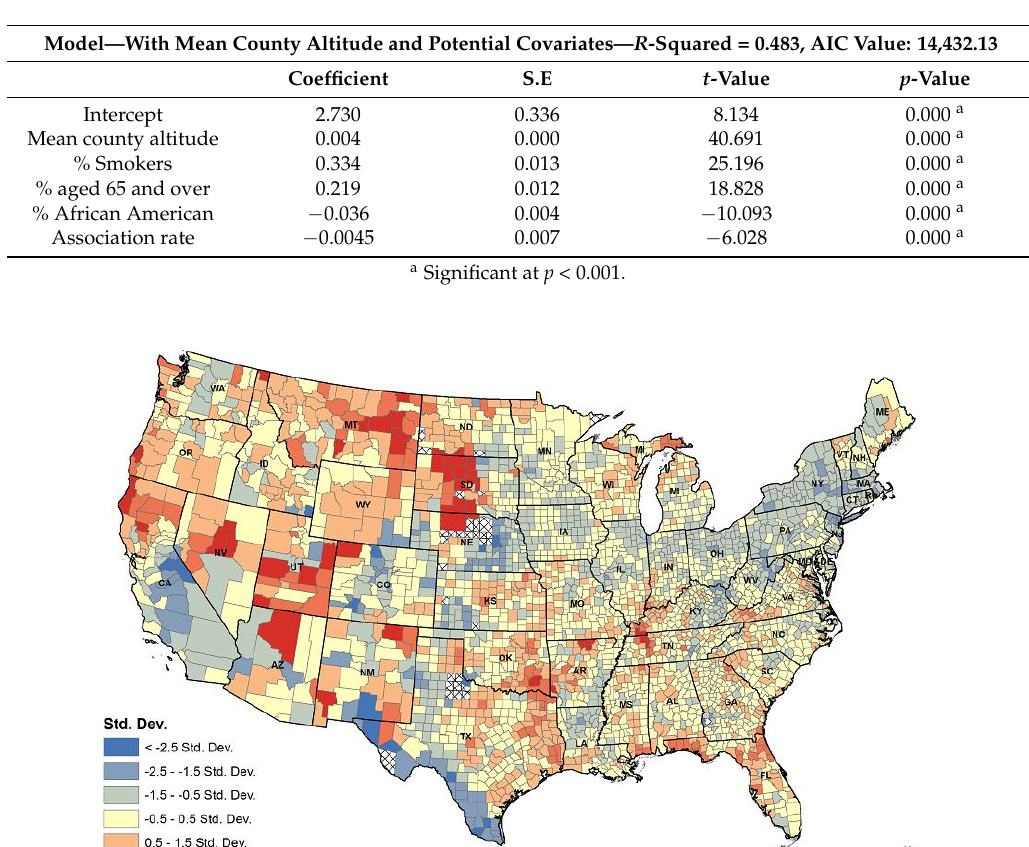
Table 4. Partial results from the OLS regression model